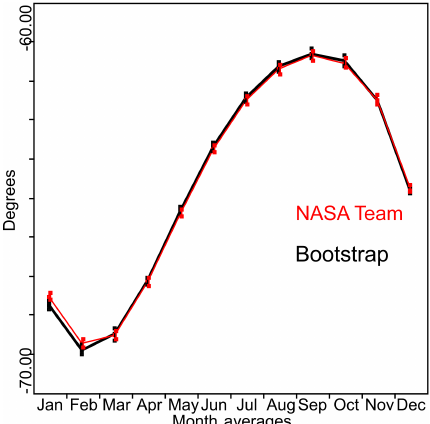
Figure 4. Location of the mean 1981–2010 outer marginal ice edge for both the NASA Team and Bootstrap